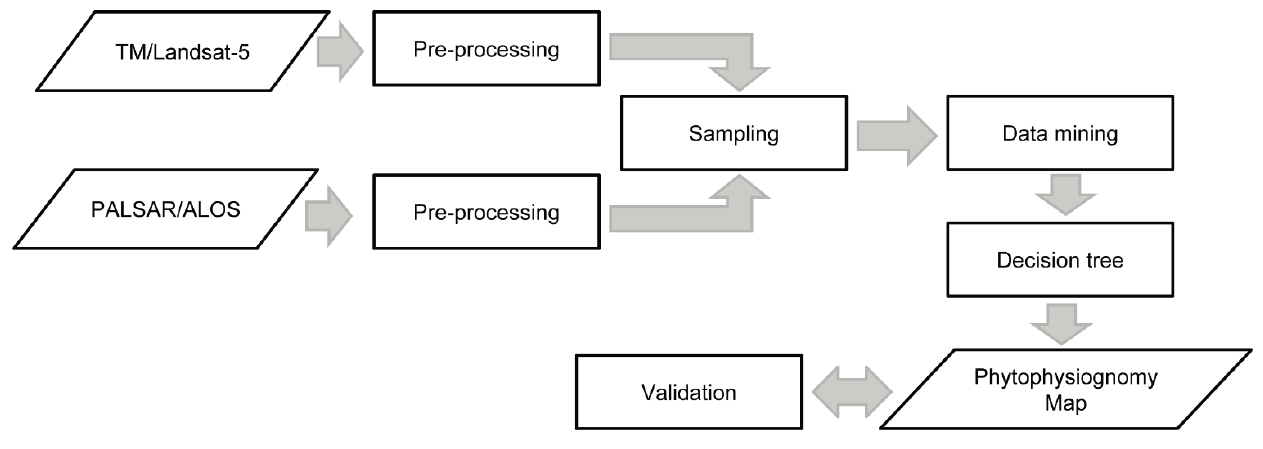
Figure 3. Steps applied for processing the remote sensing